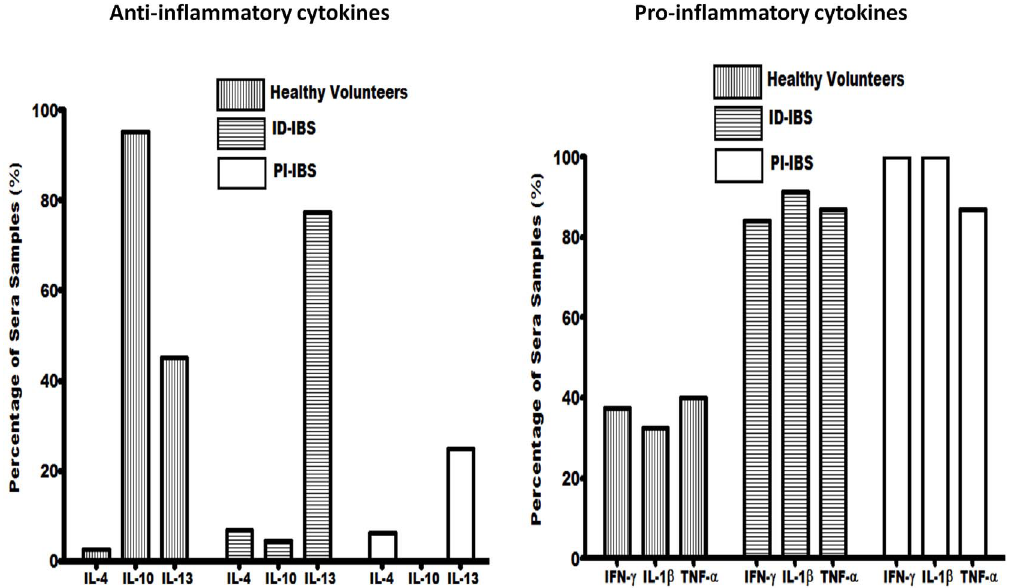
Figure 4. Comparison of the proportion of sera samples with detectable anti-inflammatory cytokines (IL-4, IL-10, and IL-13) and pro-inflammatory cytokines (IFN- c , IL-1 b , and TNF- a ). The proportion of sera with detectable anti-inflammatory and pro-inflammatory cytokines were determined following the analysis of sera from 44 ID-IBS, 16 PI-IBS, and 40 healthy volunteers using the Proteome Profiler Human Cytokine Array Panel A kit (R&D Systems, Minneapolis, MN). Cytokine Array assay and highlight the importance of MCP-1 and MIP-1 b in the pathogenesis of IBS.